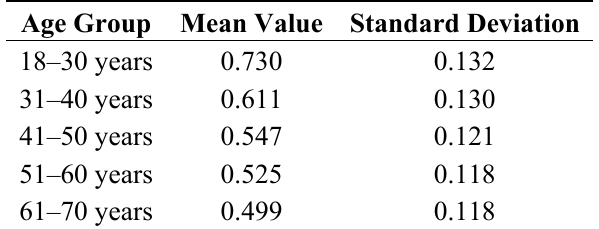
Table 2. Skin elasticity (R2 parameter) mean basal values and standard